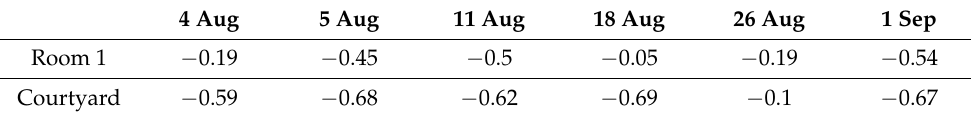
Table 8. The air temperature and velocity correlation coefficient for Room 1 and the courtyard. 4 Aug